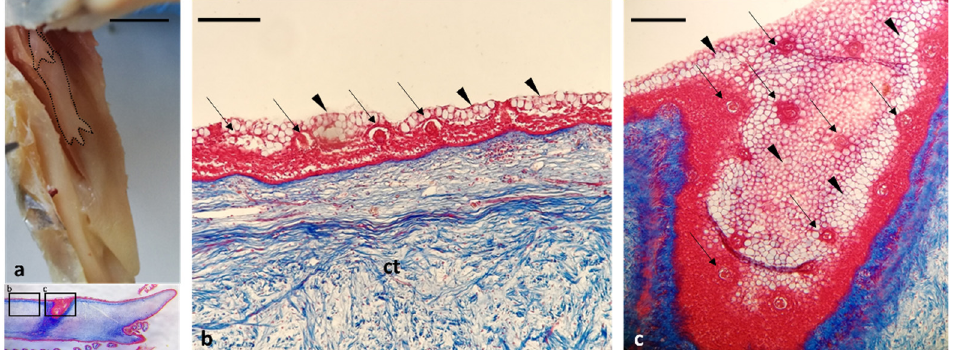
Figure 7. ( a ) Gross anatomy: photographs of the tubular organs with digitiform ends (dotted area), stereomicrographs sagittal sections of digitiform ends (insert). ( b ) Light micrograph corresponding to the b insert: mucosa with several taste buds (arrows) and mucous cells (arrowheads). ( c ) Light micrograph corresponding to the c insert: invaginations or pockets-like structure richly covered by taste buds (arrows) and mucous cells (arrowhead). Masson Trichrome with Aniline Blue staining ( a – c ). Scale bar: 1 cm ( a ), 500 μ m (insert, in the box below ( a )), 100 μ m ( b ), 50 μ m ( c ).